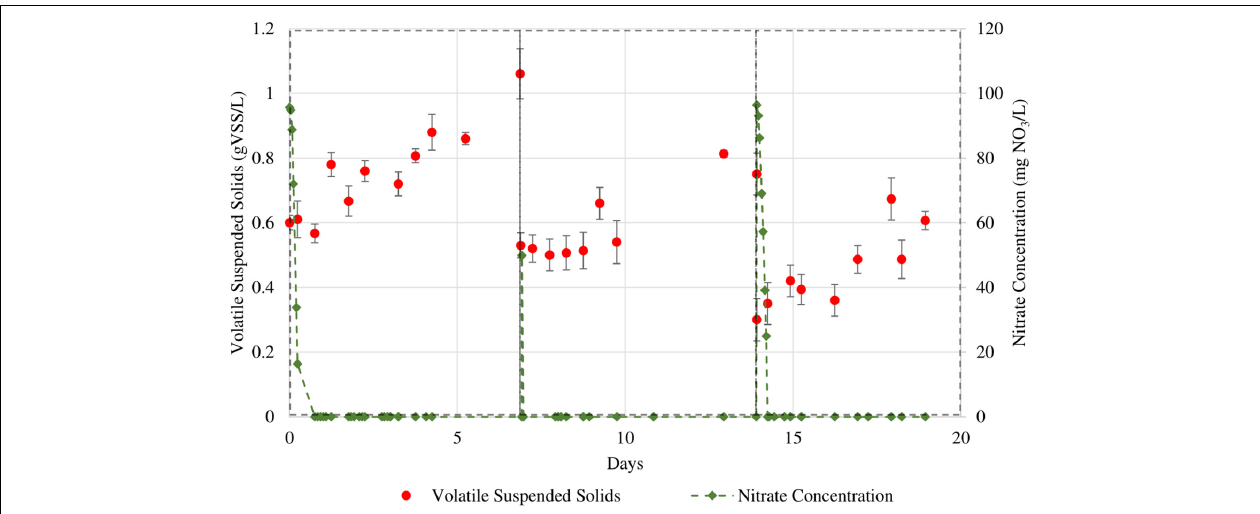
FIGURE 6 | Sequential batches of T. chuii in which nitrate levels were more closely monitored. The initial NO 3 concentrations for the 3 cycles are 95, 50, and 96 mg/L respectively.